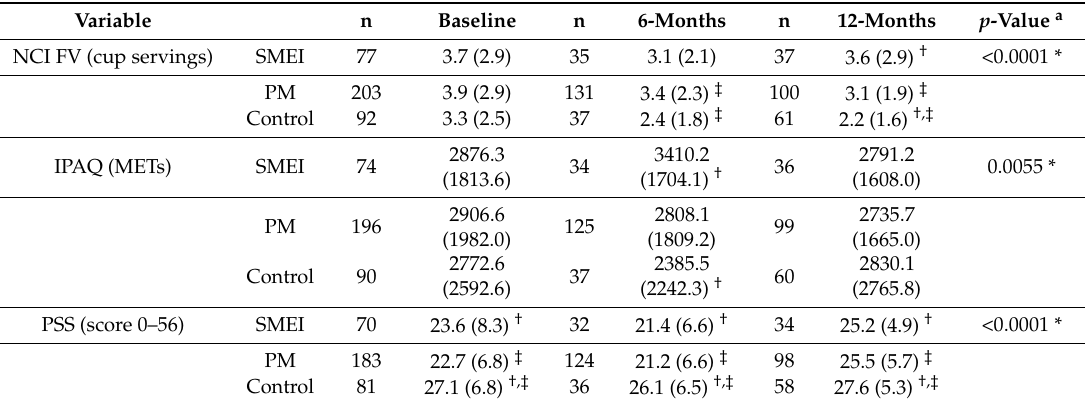
Table 2. One-way ANOVA of behavioral changes across time and group.